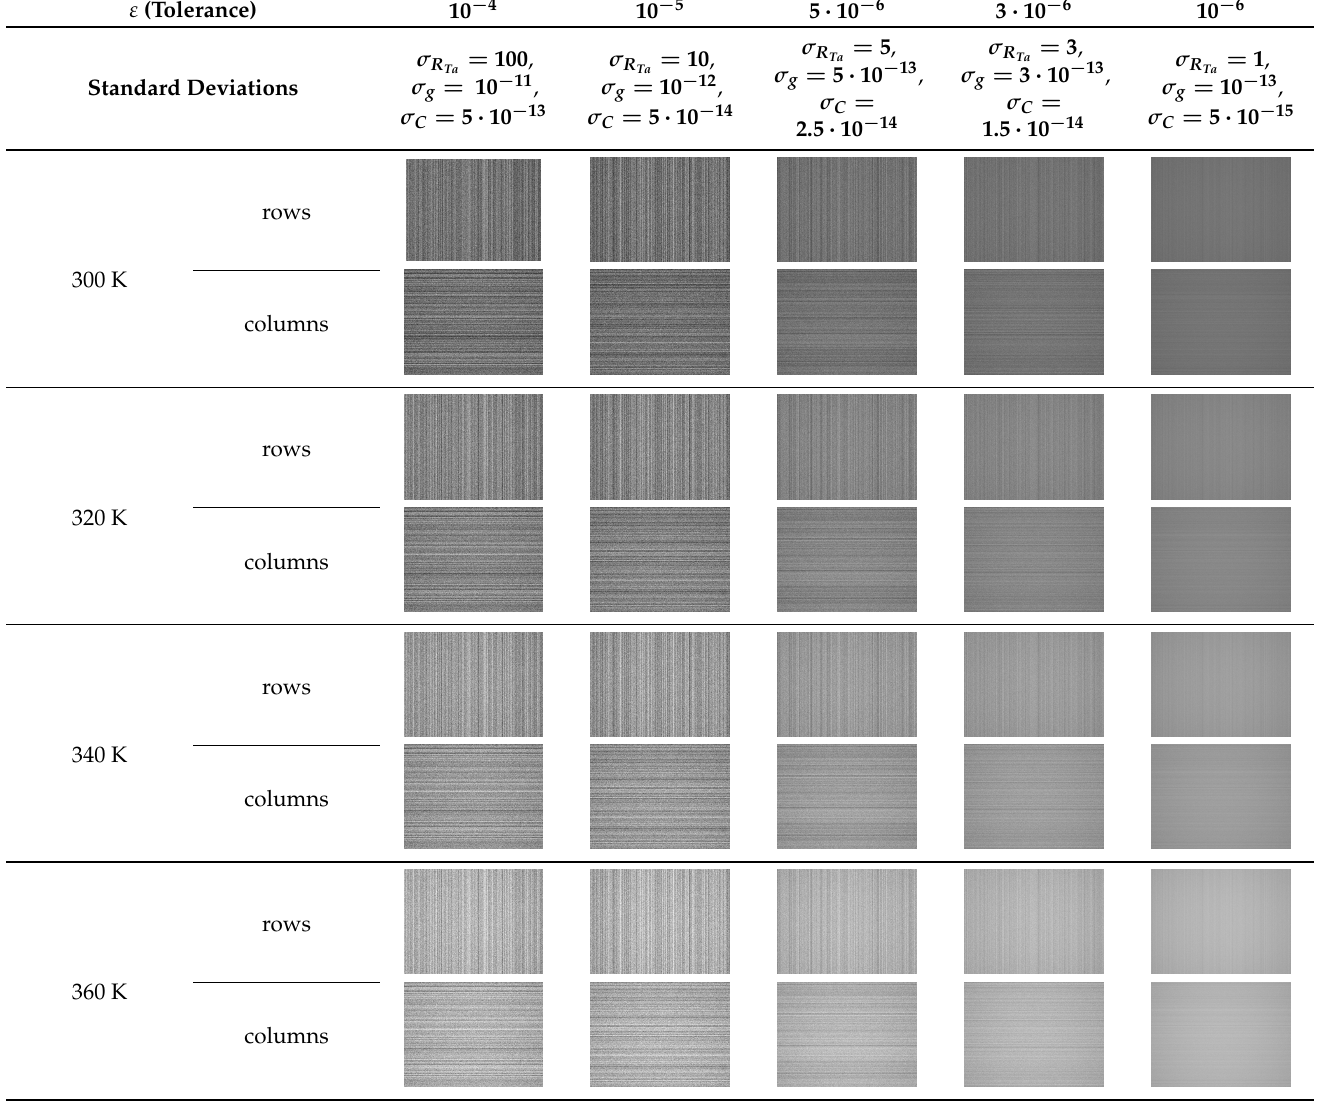
10 − 9 [W s/K]) · = ε R Ta . Ta